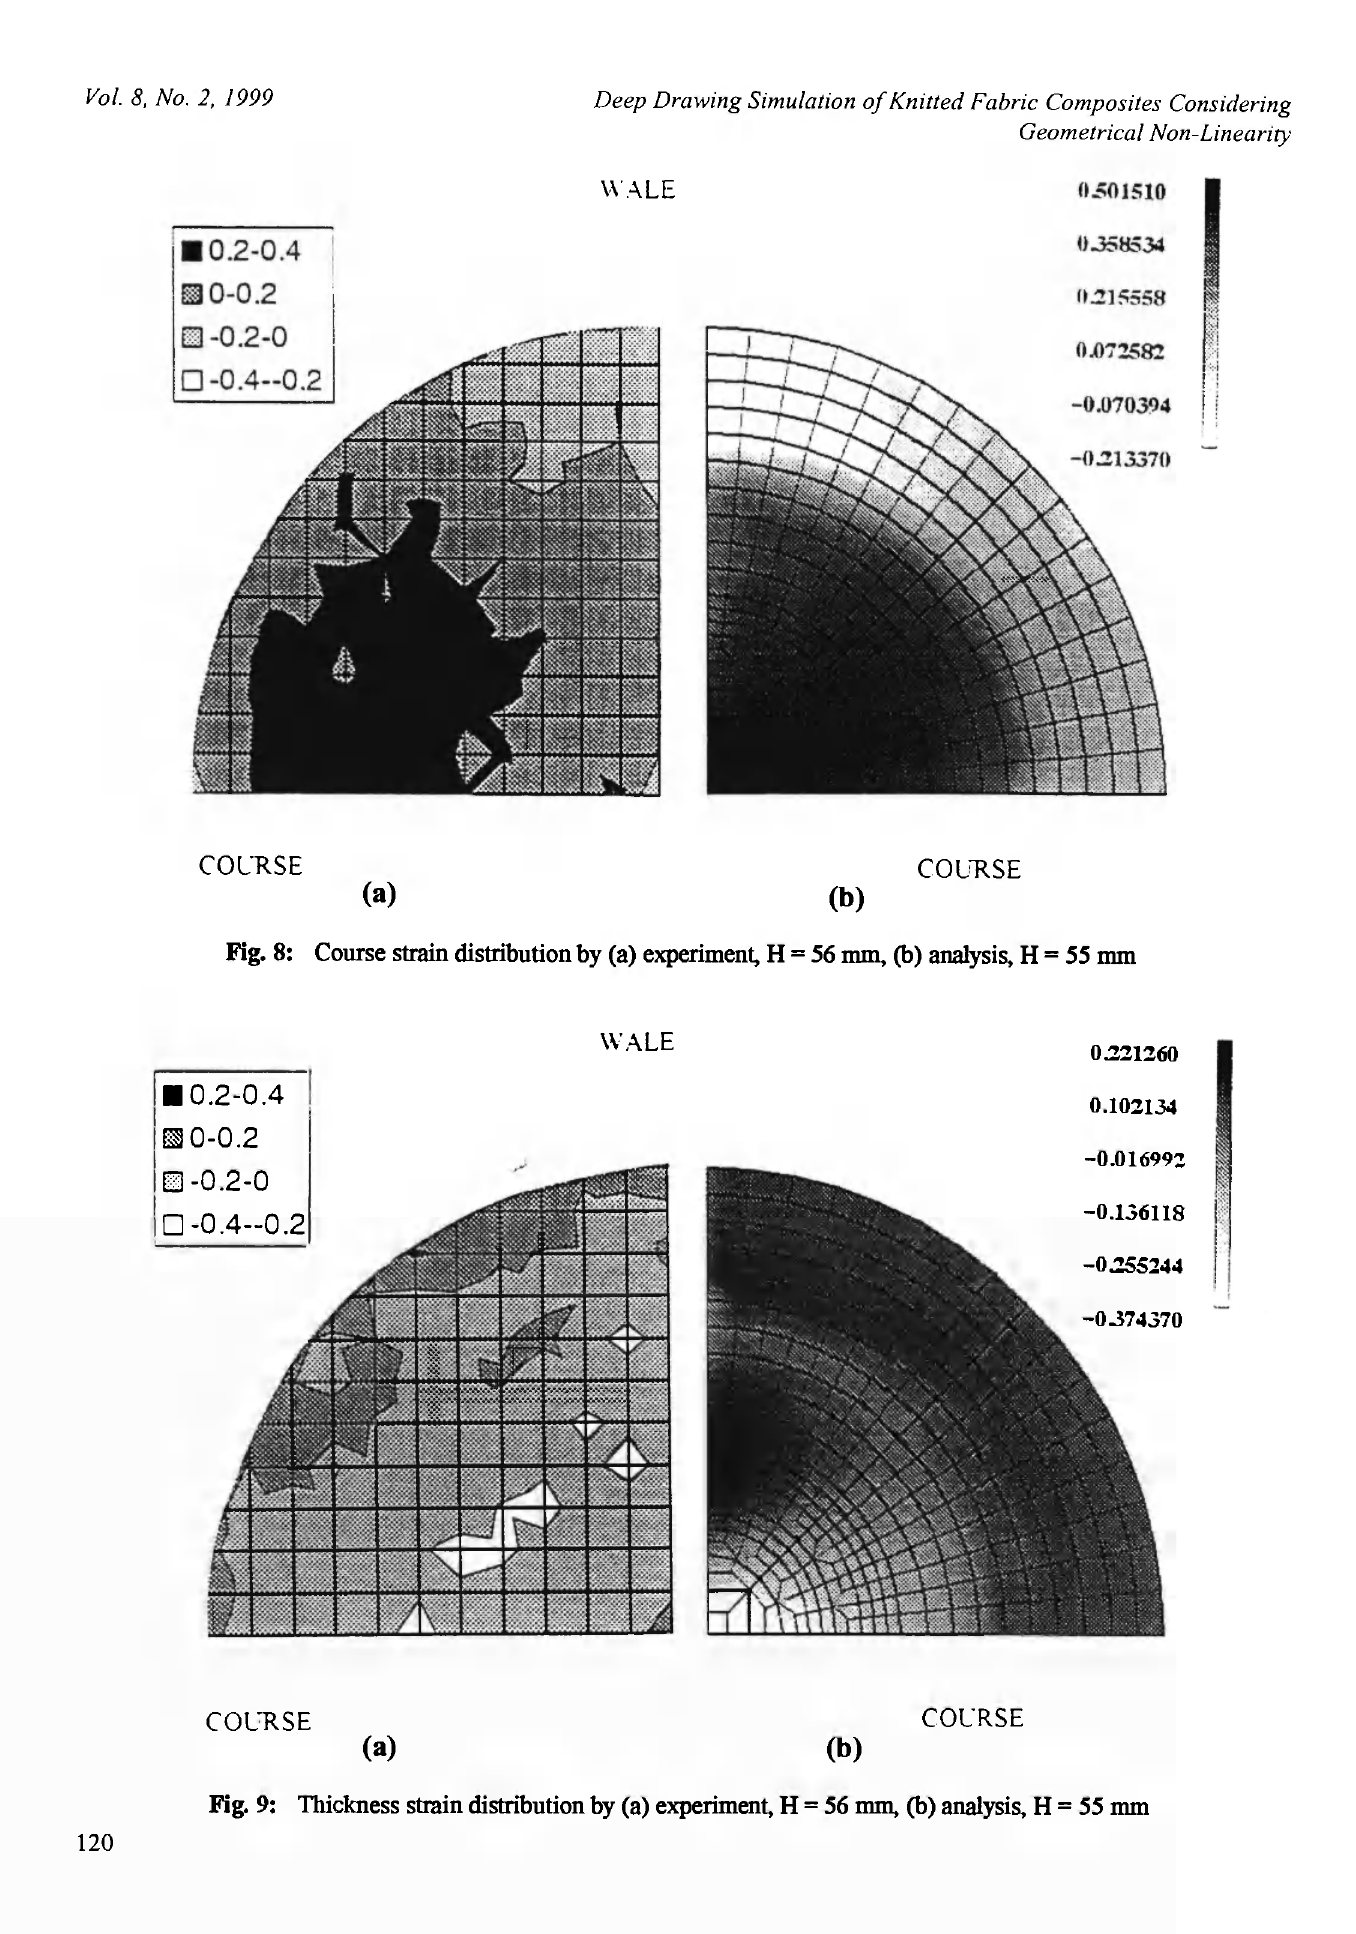
Fig. 9: Thickness strain distribution by (a) experiment, Η = 56 mm, (b) analysis, Η = 55